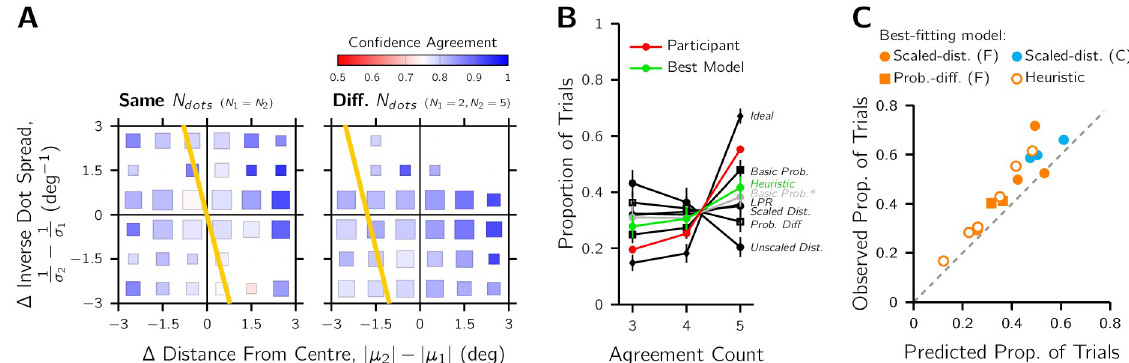
Fig 5. Confidence agreement results ( n = 15). Confidence agreement was calculated per trial as the proportion of the most-selected confidence choice for the participants who did a 3-, 4-, or 5-pass version of the experiment (Fig 2B). A) Heatmaps of average confidence agreement according to the properties of the two stimuli displayed, pooled across observers. Gold: the indifference lines where each interval is equally likely to be selected as more confident according to the preliminary analyses (Fig 3B). B) Comparing the 5-pass confidence agreement of a representative example participant (red; #11) with the predicted confidence agreement of the models. Green: the best-fitting model for this observer (Heuristic model). Black: other models (flat- and centred-prior variants had similar confidence agreement counts so only the flat-prior variant is shown). Grey: the Basic-Probability model with additional late noise (1% SD). Model predictions calculated from 100 simulated datasets using the participant-specific best-fitting parameters. Error bars: ± 2 SD. C) A comparison of the predicted and the observed proportion of trials for the highest agreement count. Each marker is an individual participant, where marker style indicates their best-fitting model (“F” refers to the flat-prior variant and “C” the centred-prior variant). The best-fitting model per observer was used for the confidence-agreement prediction. Dashed line of equality is also